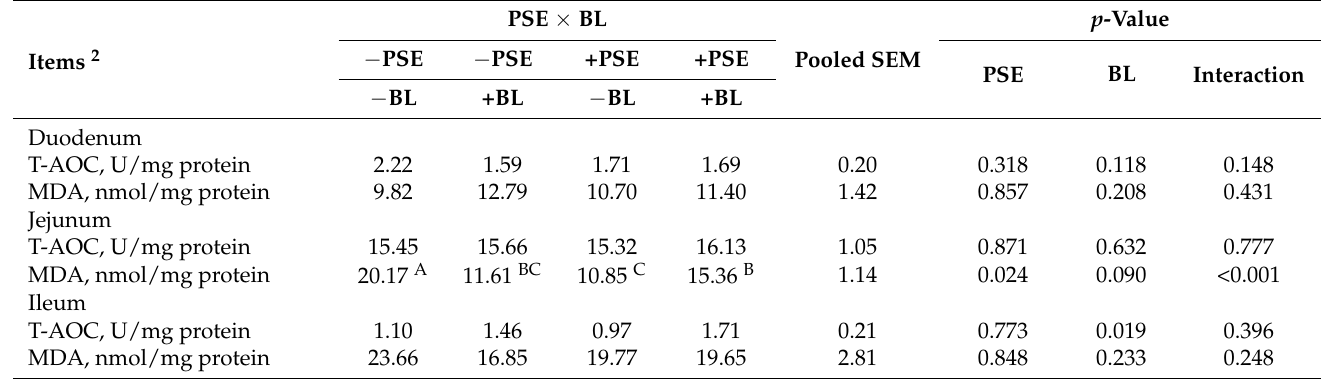
Table 9. Effects of BL and PSE on intestinal antioxidant indices of weaned piglets 1